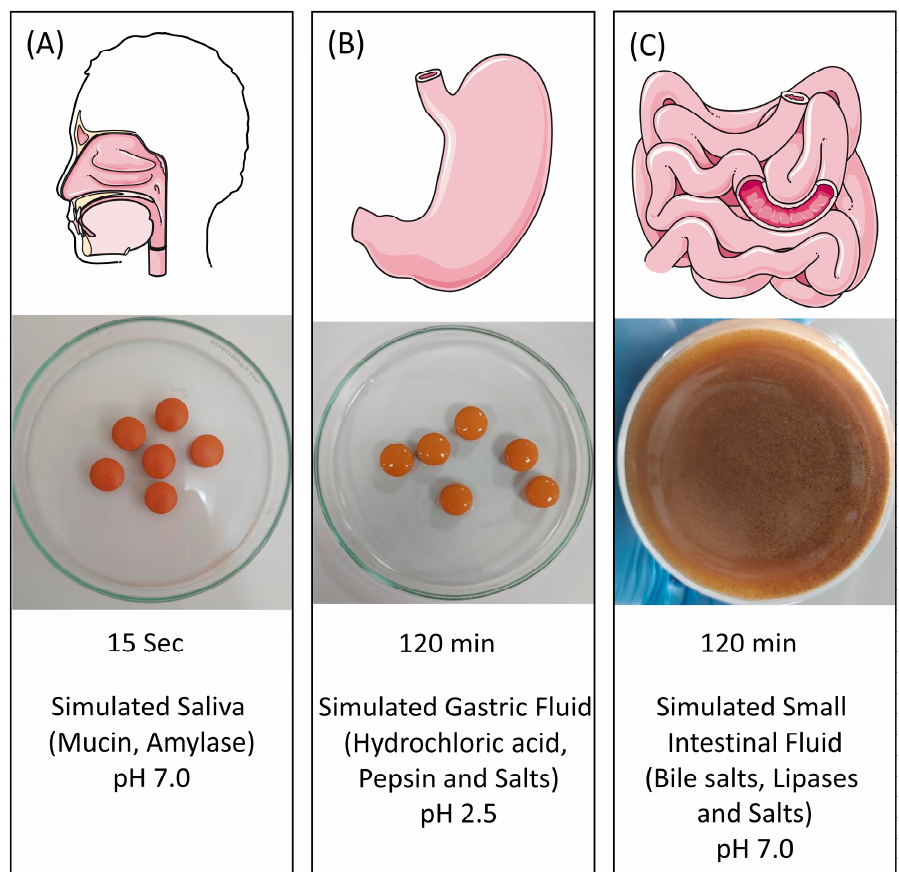
Figure 4. In vitro enzymatic digestion of EC Cologrit tablets in simulated gut model. Methacrylic acid-ethyl acrylate copolymer (1:1) type a (MMA) coated tablets of the Cologrit formulation were tested for solubility in the ( A ) mouth phase (pH 7.0) for 15 s, ( B ) stomach phase (pH 2.5) for 120 min, and ( C ) intestinal phase (pH 7.0) for 120 min, each with a different enzyme and ionic combination.